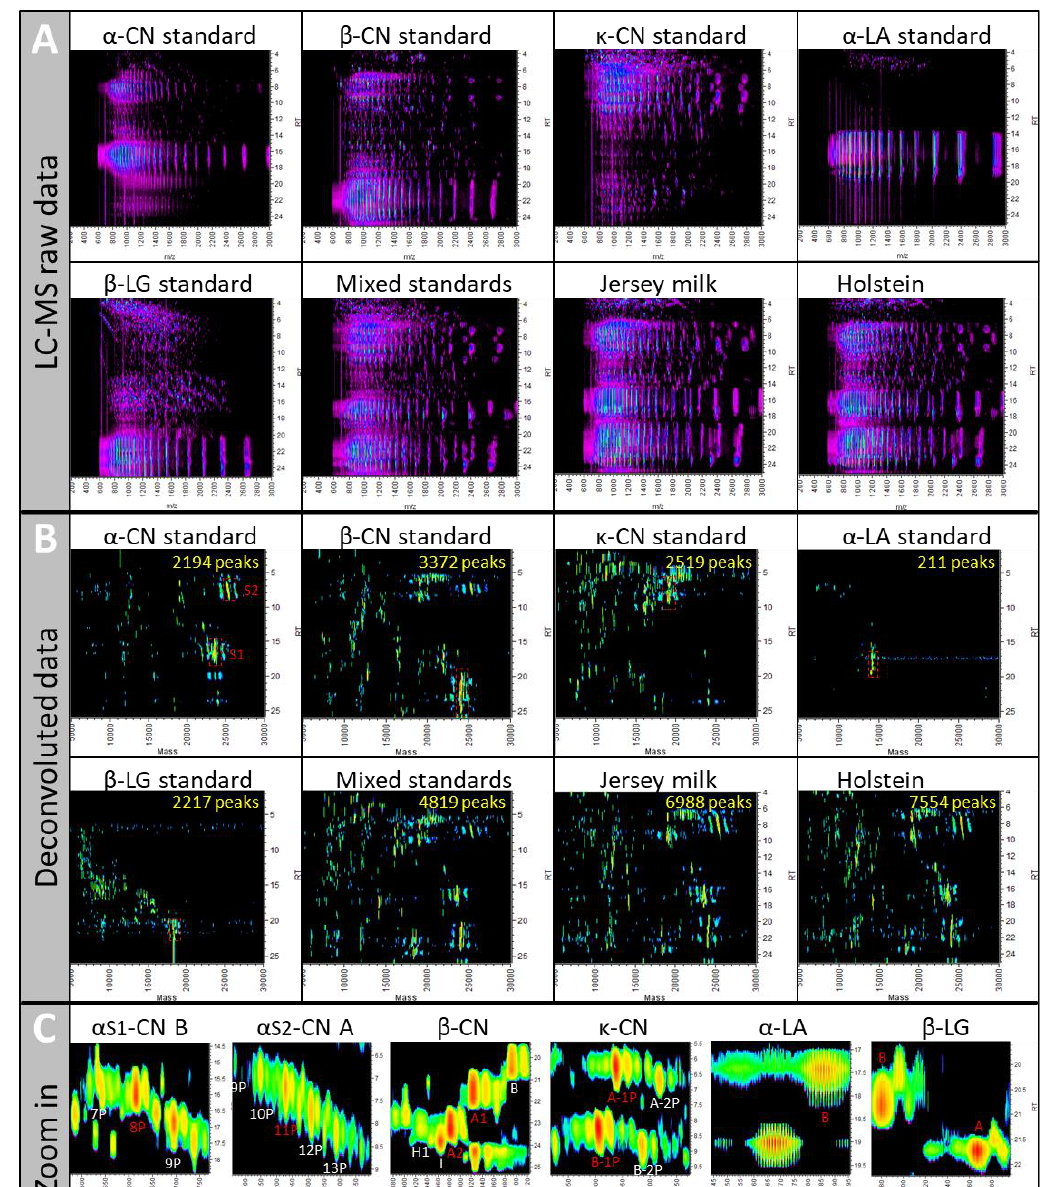
Figure 2. LC-MS maps of the different samples (individual protein standards, mixed protein standards, Jersey milk, and Holstein milk) visualised in Genedata Refiner pre- and post-deconvolution with m / z on the x axis and LC retention time in min on the y axis. ( A ) LC-MS1 unprocessed raw data. ( B ) Deconvoluted data displaying proteins of interest in the red boxed areas. The total numbers of deconvoluted peaks detected are indicated in yellow. ( C ) Close-ups of the boxed areas of the individual protein standards; the nine proteoforms highlighted in red are the proteins targeted for method validation.